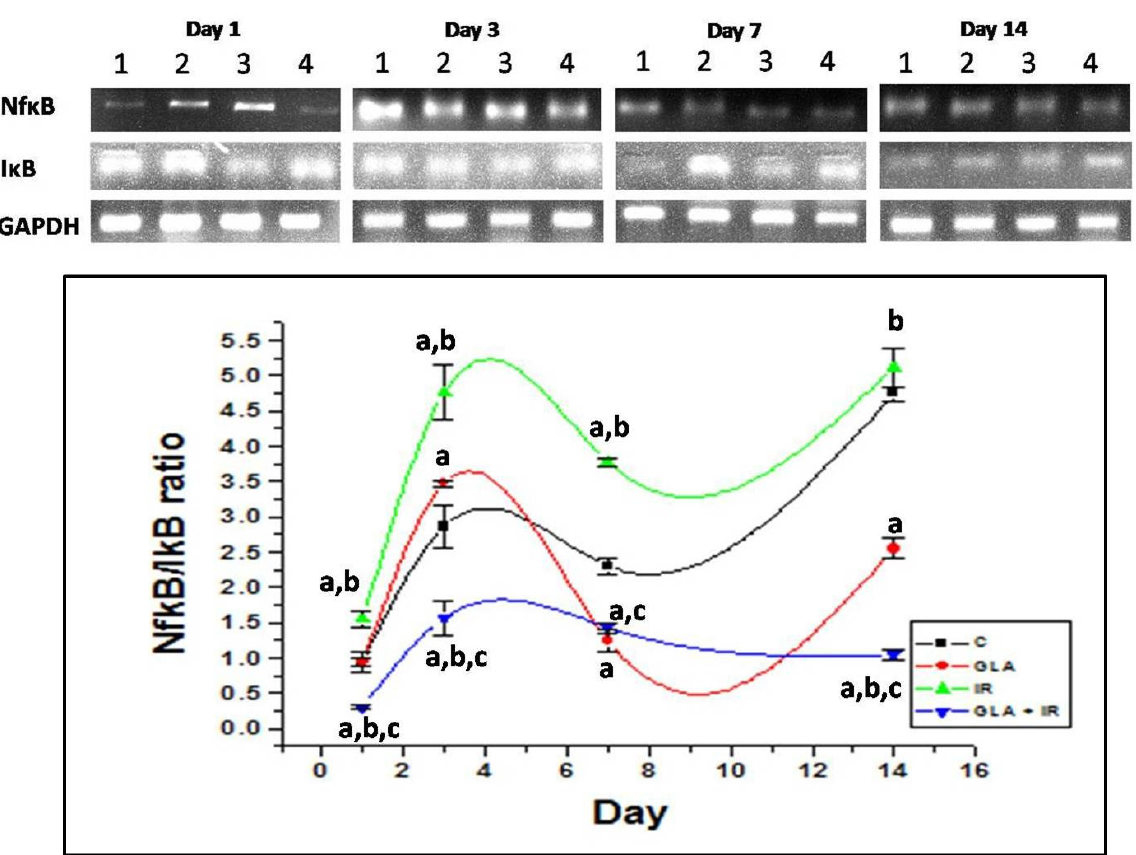
Figure 14. Effect of GLA and radiation on the expression of NF-kB/IkB in duodenal tissue of mice on days 1, 3, 7, and 14. Values (n = 3) are expressed as mean ± SEM. a , b , c Significant ( p < 0.01) when compared with control, GLA, and IR, respectively. 1, C; 2, GLA; 3, IR; and 4, GLA + IR. C, control; GLA, gamma-linolenic acid; IR, irradiation (7.5 Gy).